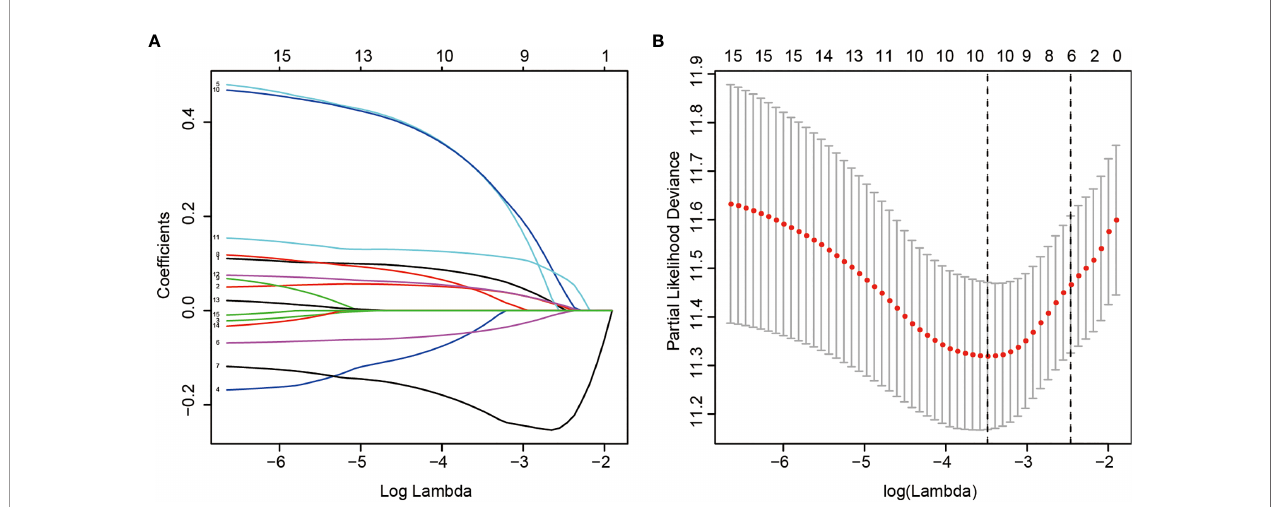
FIGURE 1 | LASSO regression analysis of 15 DEHGs. Ten-fold cross-validation was applied to calculate the best lambda, which leads to a minimum mean cross- validated error (A) . A total of 6 DEHGs were adopted for the LASSO model (B)